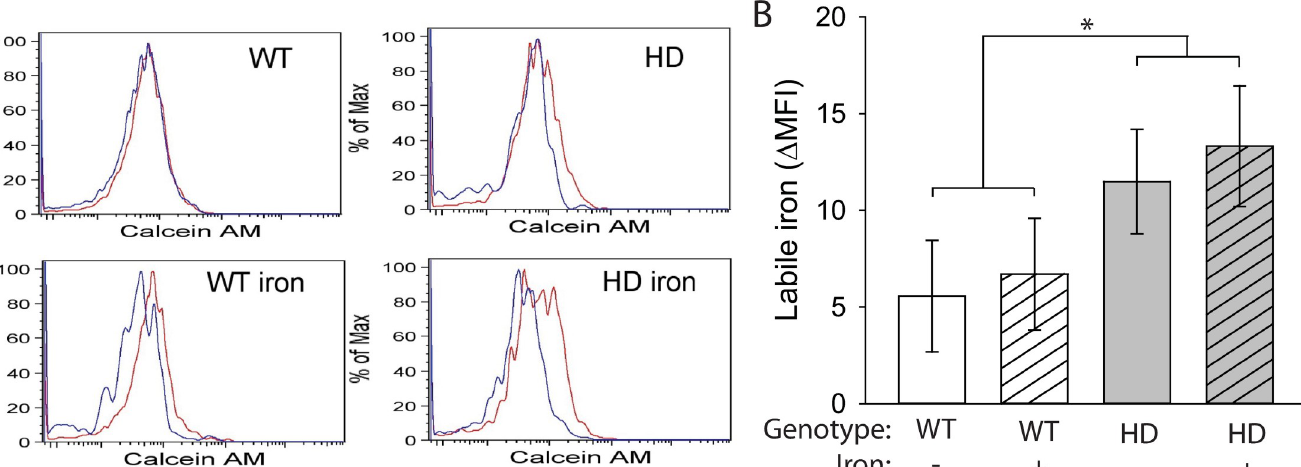
PLOS ONE | https://doi.org/10.1371/journal.pone.0250606 May 14,